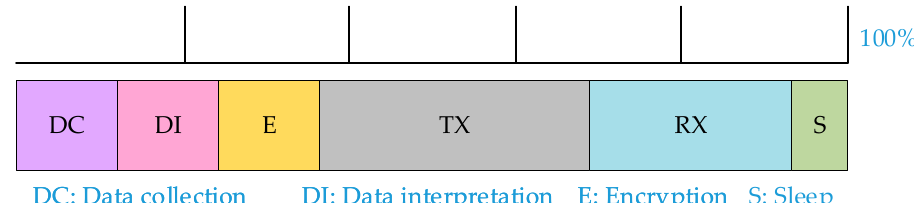
Figure 14. Average energy distribution chart of three applications.